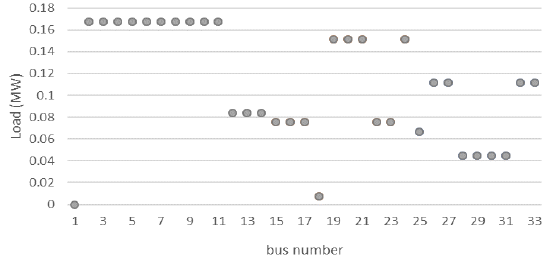
Figure 6. The 33-bus system load distribution.